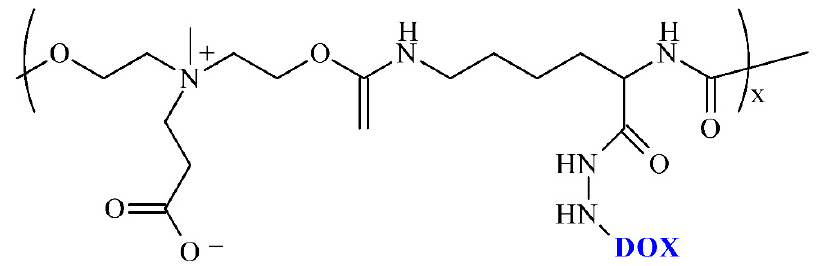
Figure 8. Structure conjugates of polyurethane and doxorubicin. A novel dendritic polyurethane-based prodrug with a drug content of 18.9% was obtained by conjugating DOX onto the end groups of the functionalized dendritic PU via acid-labile imine bonds [58]. The PU-DDSs showed excellent pH/ultrasound dual- triggered drug release performance, with drug leakage of only 4% at pH 7.4 but a cumulative release of 14% and 88% at pH 5.0 without and with ultrasound, respectively.